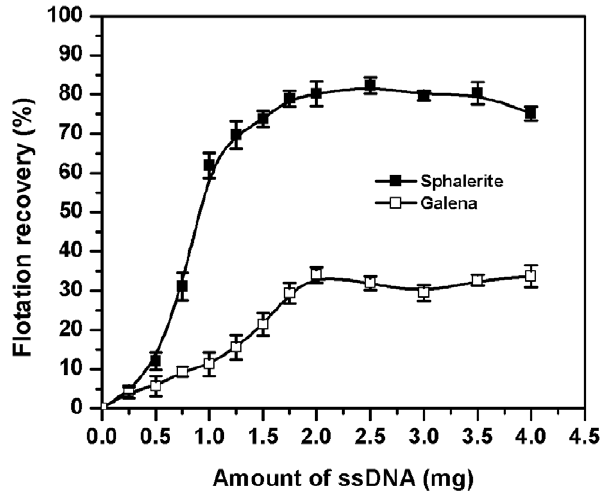
Figure 5. Flotation recovery of sphalerite and galena as a function of the ssDNA concentration.